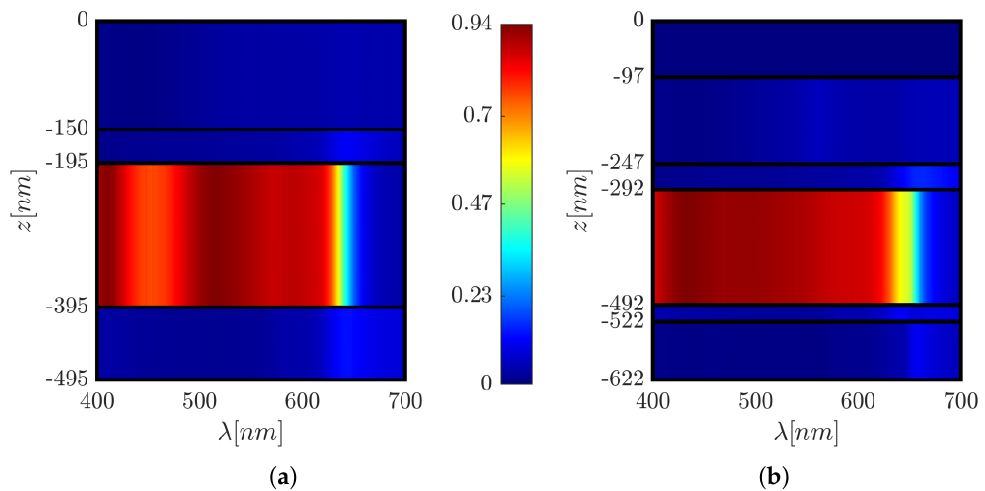
Figure 4. Color map of the spectral absorptance in each layer. ( a ) Reference structure. ( b ) Solar cell structure C.